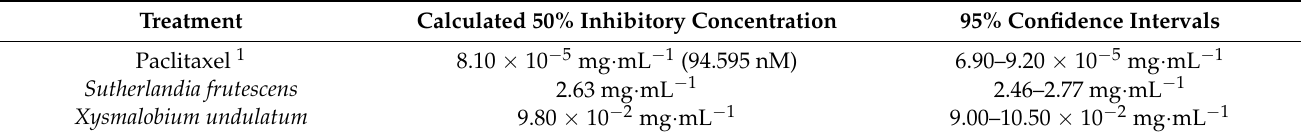
Table 1. Half maximal inhibitory concentration of cell metabolic activity (IC 50 ) of the treatments, relative to an untreated control, in LS180 cells following 96 h exposure, as determined with the Probit analysis.